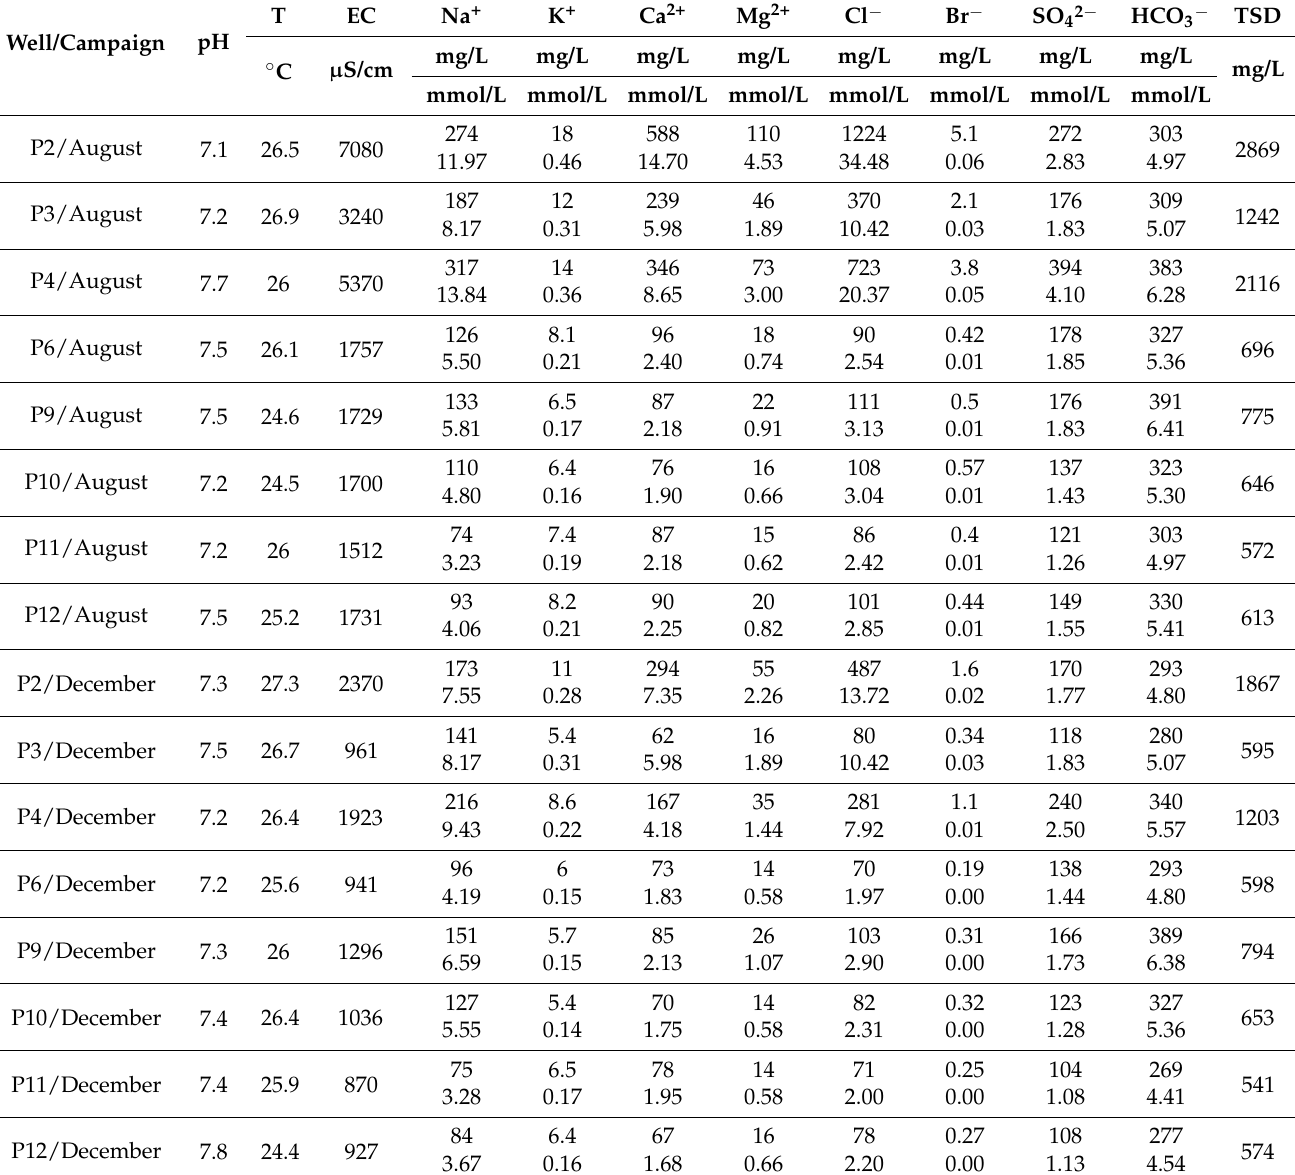
Table 1. Hydrochemical data of groundwater in the Manglaralto river basin from August 2018 and December 2018. Temperature, T ( ◦ C), anions and cations (mg/L) and (mmol/L), EC ( µ S/cm), TDS (mg/L).